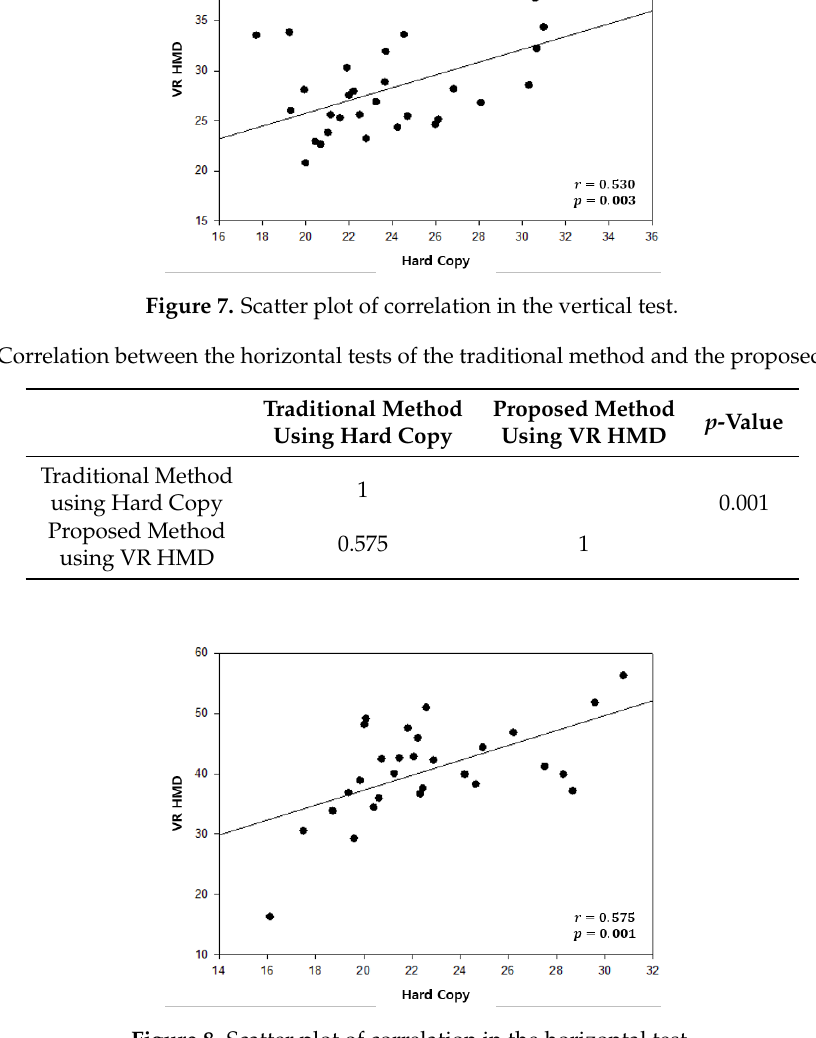
Figure 8. Scatter plot of correlation in the horizontal